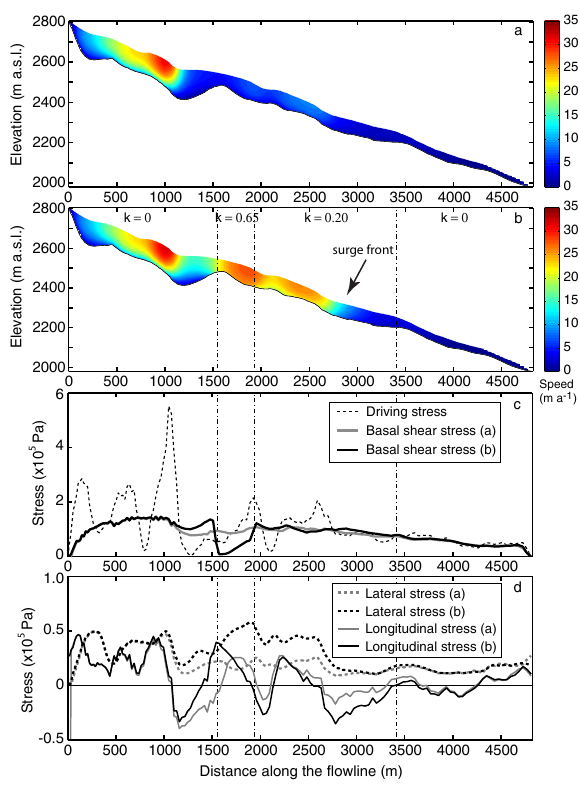
Fig. 7. Modelled cross-sections of glacier flow speed with A = 2 . 4 × 10 − 24 Pa − 3 s − 1 , m max = 0 . 25 and λ max = 6m. (a) k = 0. (b) k ≥ 0 and variable along the flowline. This cross-section cor- responds to the annual flow-speed simulation in Fig. 6a. (c) Basal shear stress from simulations in (a) and (b) , along with the driving stress. (d) Vertically averaged lateral- and longitudinal stresses for simulations in (a) and (b)